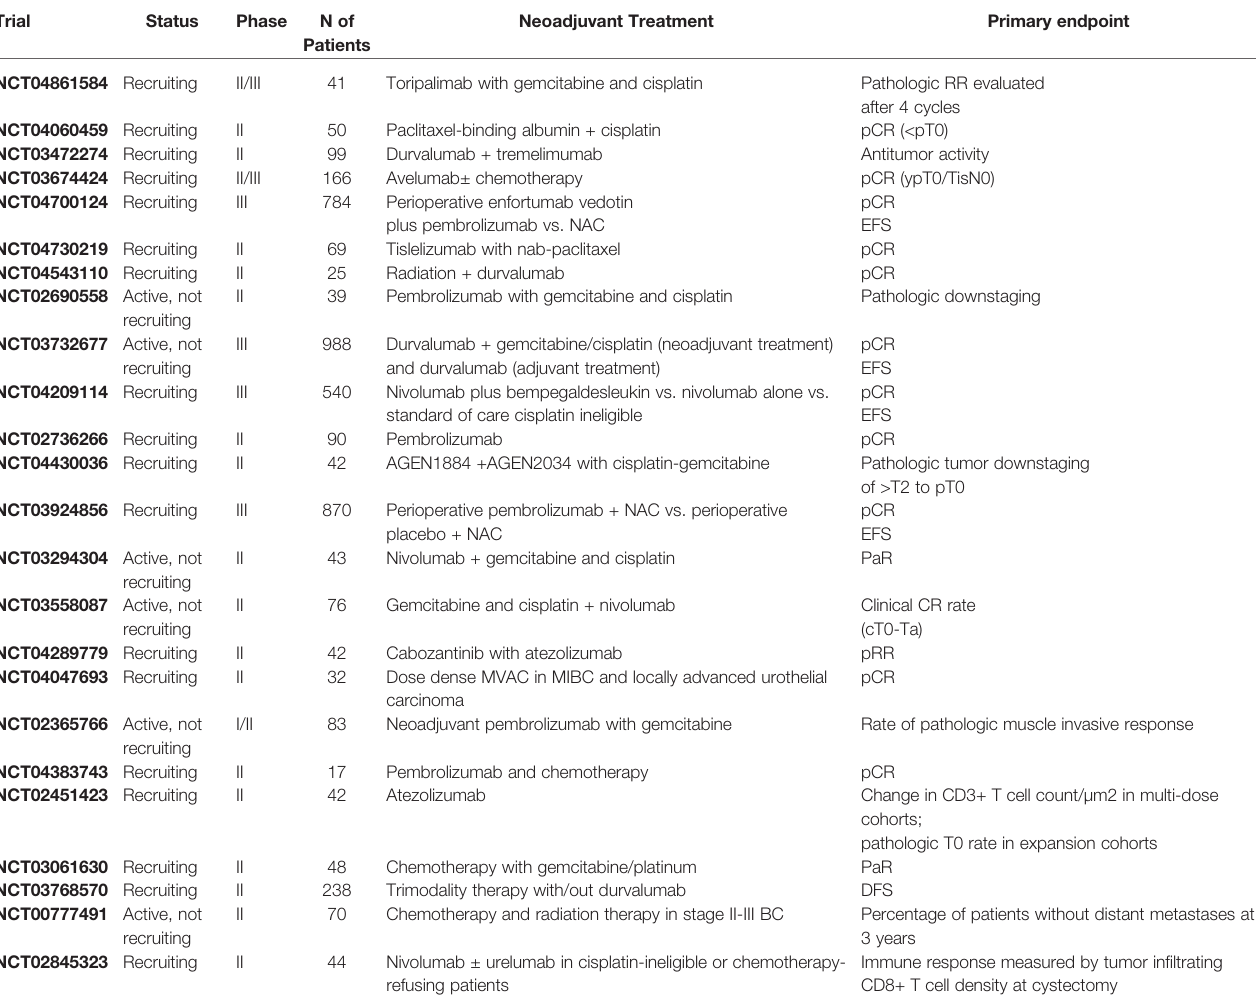
TABLE 4 | Recruiting or active, not recruiting phase II and III clinical trials with neoadjuvant therapy for